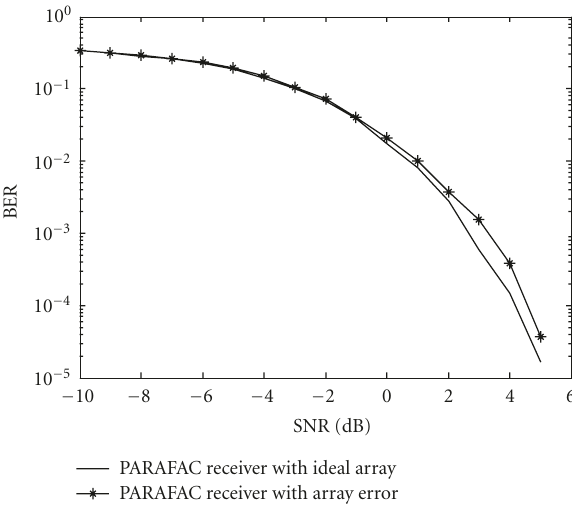
Figure 8: The algorithm performance with array error.